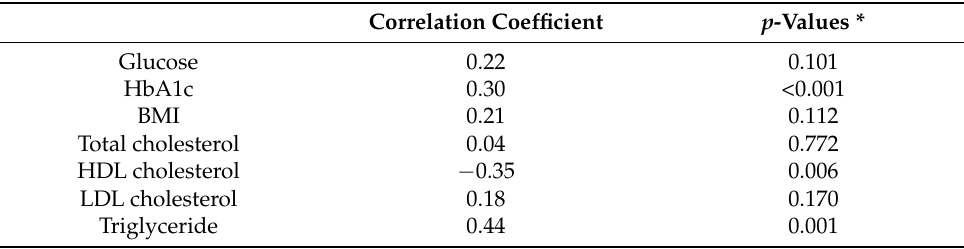
Table 2. Correlation coefficients between BCAAs and diabetes-related factors.